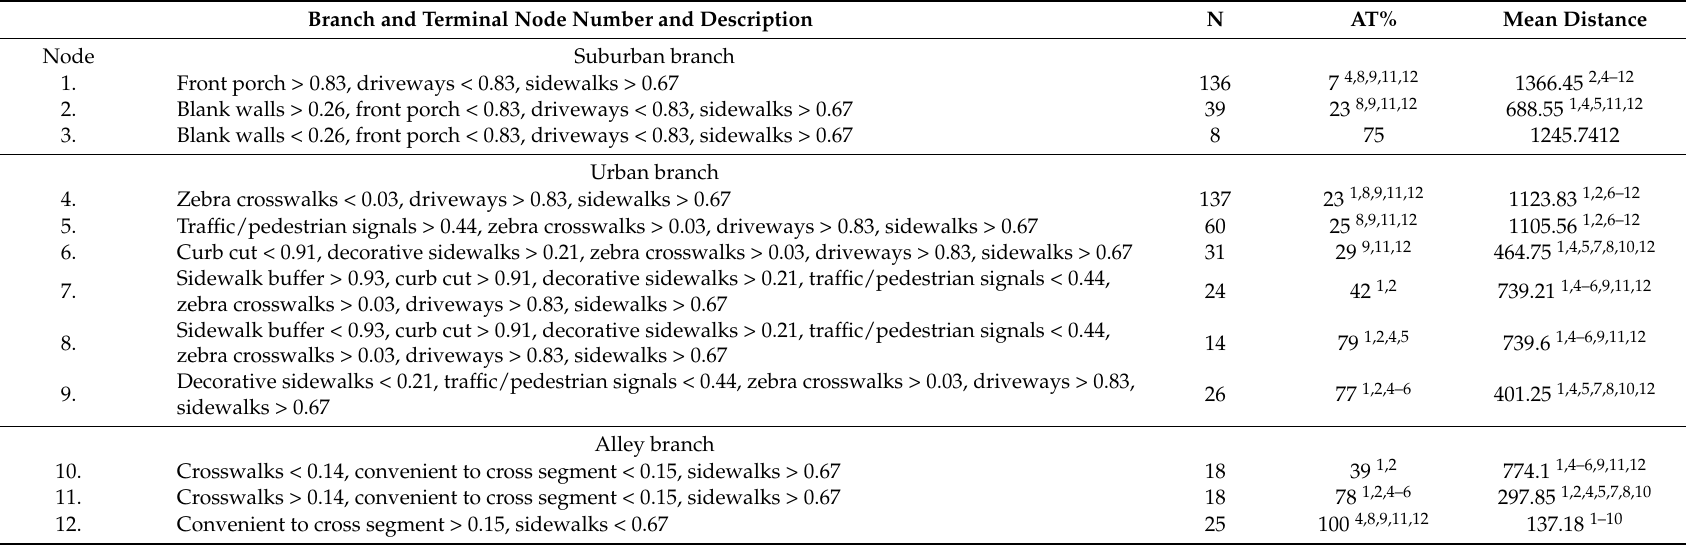
Table 3. Decision tree